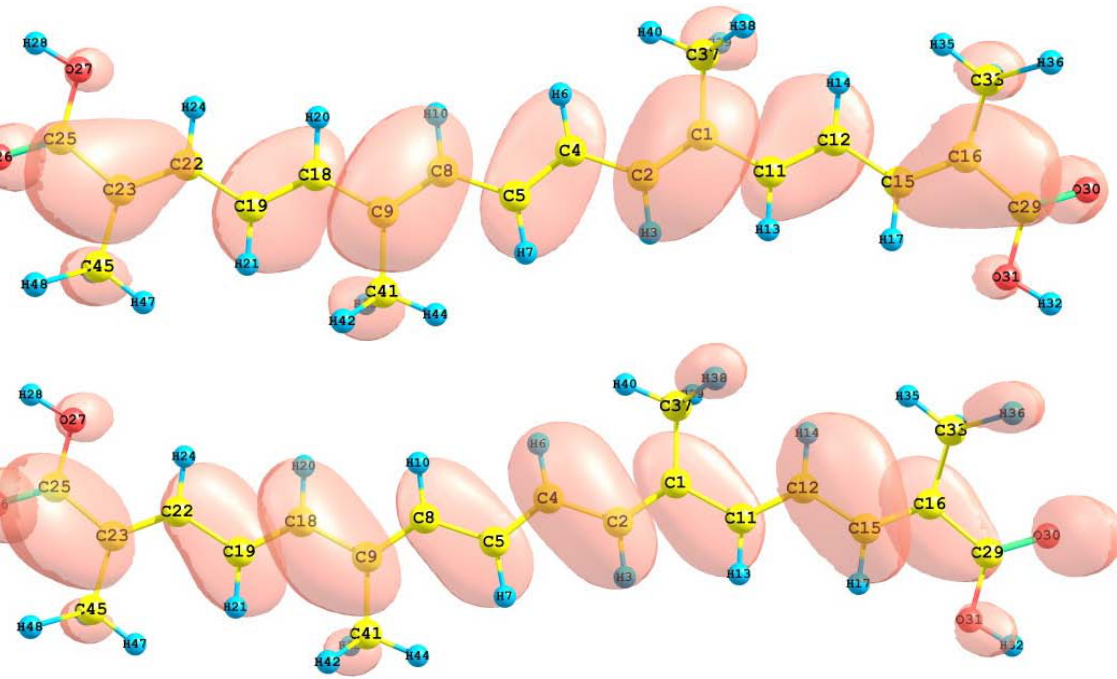
Figure 2 . HOMO and LUMO of the crocetin molecule calculated with the M05-2X/6- 31+G(d,p) level of